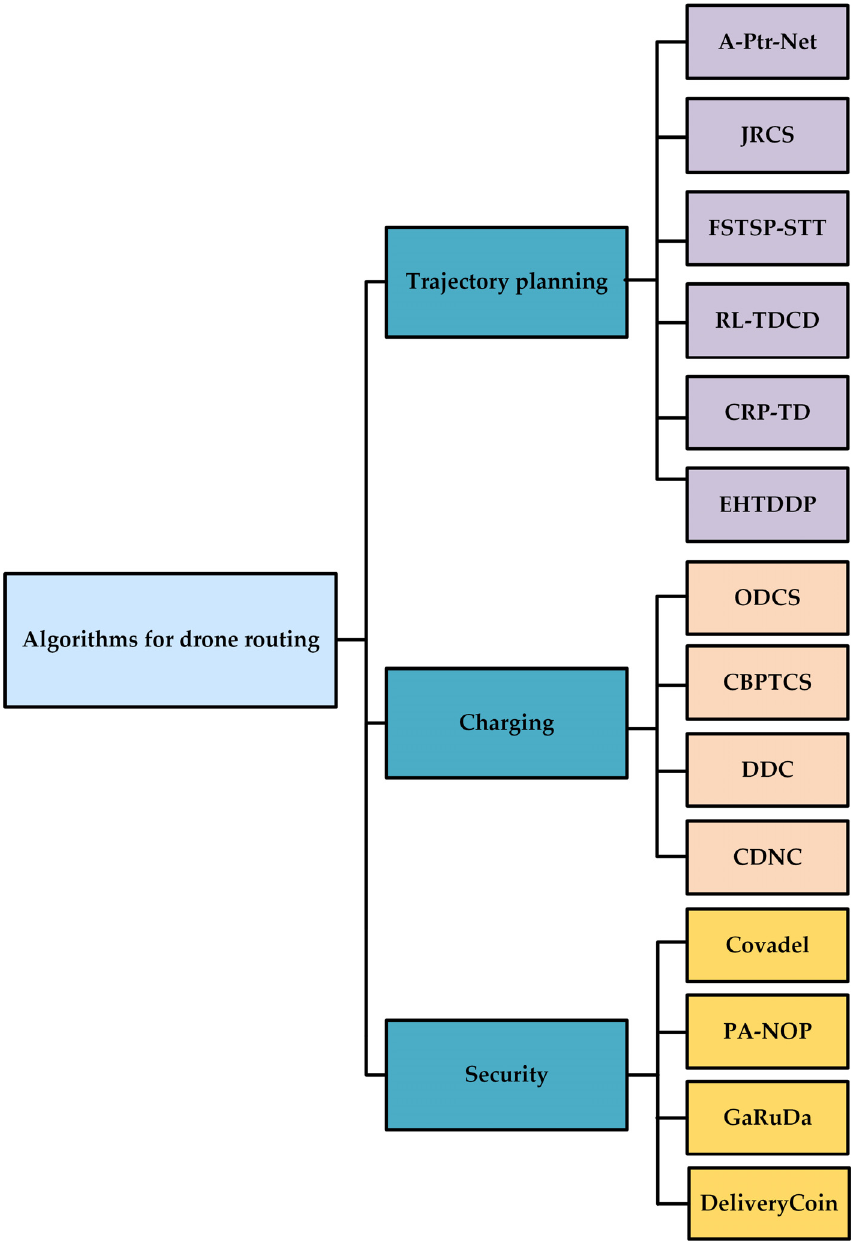
Figure 3. Taxonomy of algorithms for drone routing in drone-based delivery systems: A-Ptr-Net [6], JRCS [12], FSTSP-STT [41], RL-TDCD [42], CRP-TD [15], EHTDDP [16], ODCS [44], CBPTCS [11], DDC [17], CDNC [51], Covadel [56], PA-NOP [57], GaRuDa [58], DeliveryCoin [60].